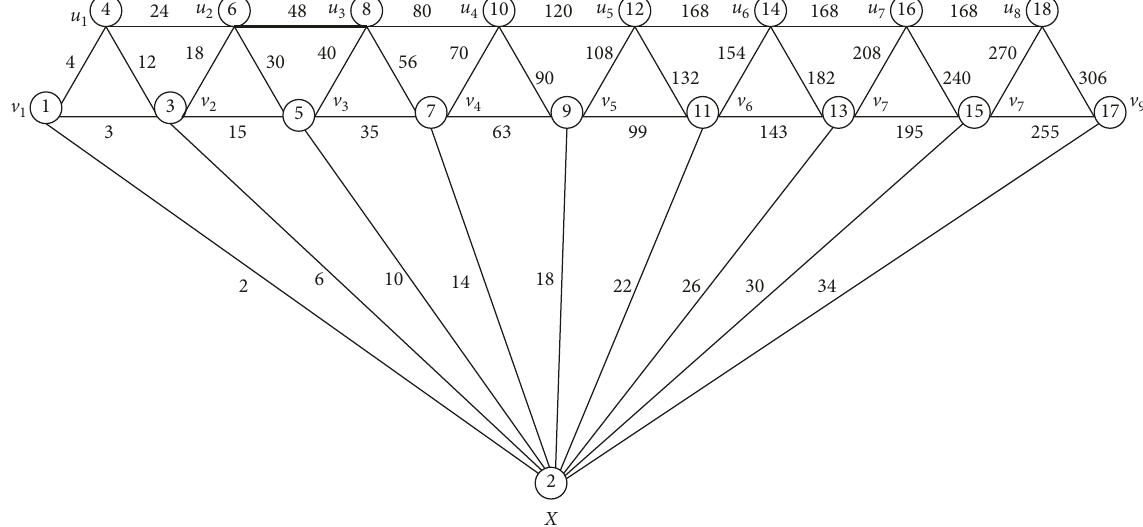
with strongly multiplicative labeling. 9